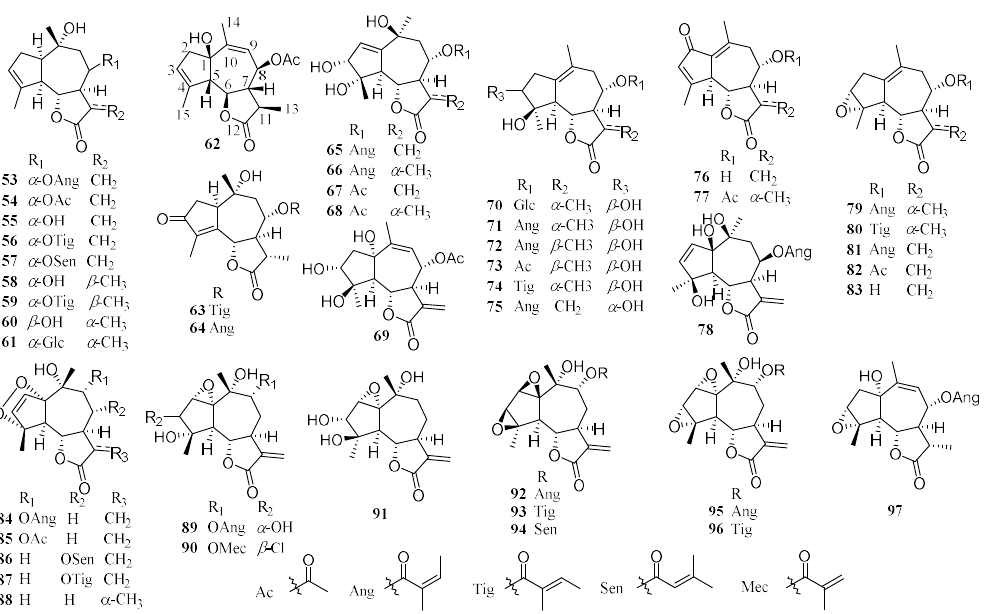
Figure 3. Guaianolide-type sesquiterpenoids from the Chrysanthemum genus.